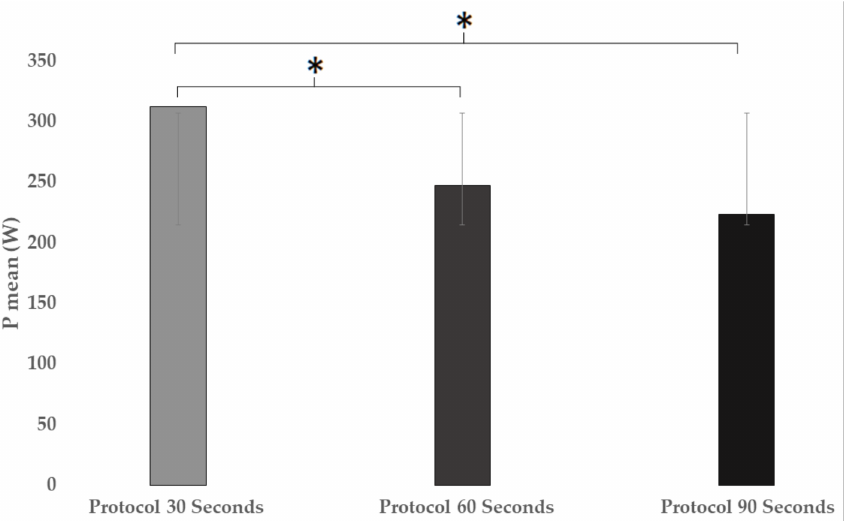
Figure 3. Average power comparison developed in different HIIT protocols. * means significant